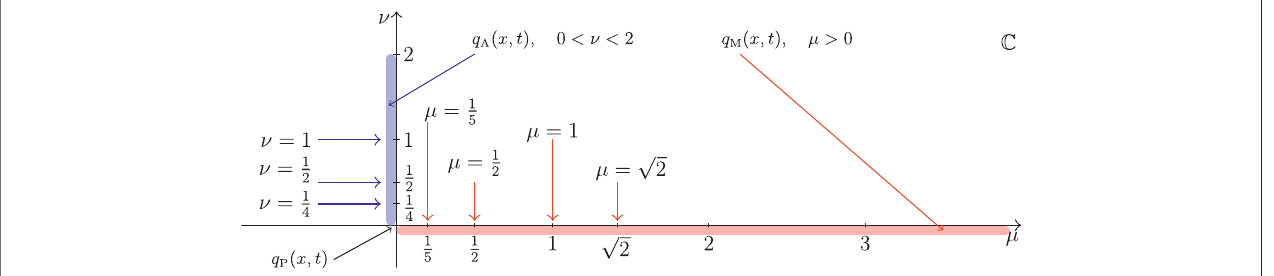
FIGURE1| Selectedparametricvalues ] and μ (cid:2) i ] displayedinthecomplexplanefortheKuznetsov-Mabreather andAkhmedievsolitonvisualizedinthissection.